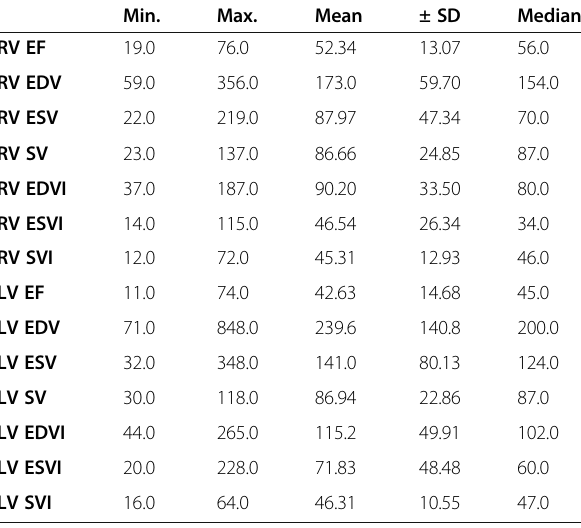
Table 5 Descriptive analysis of the studied cases according to different parameters in DCM diagnosis ( n